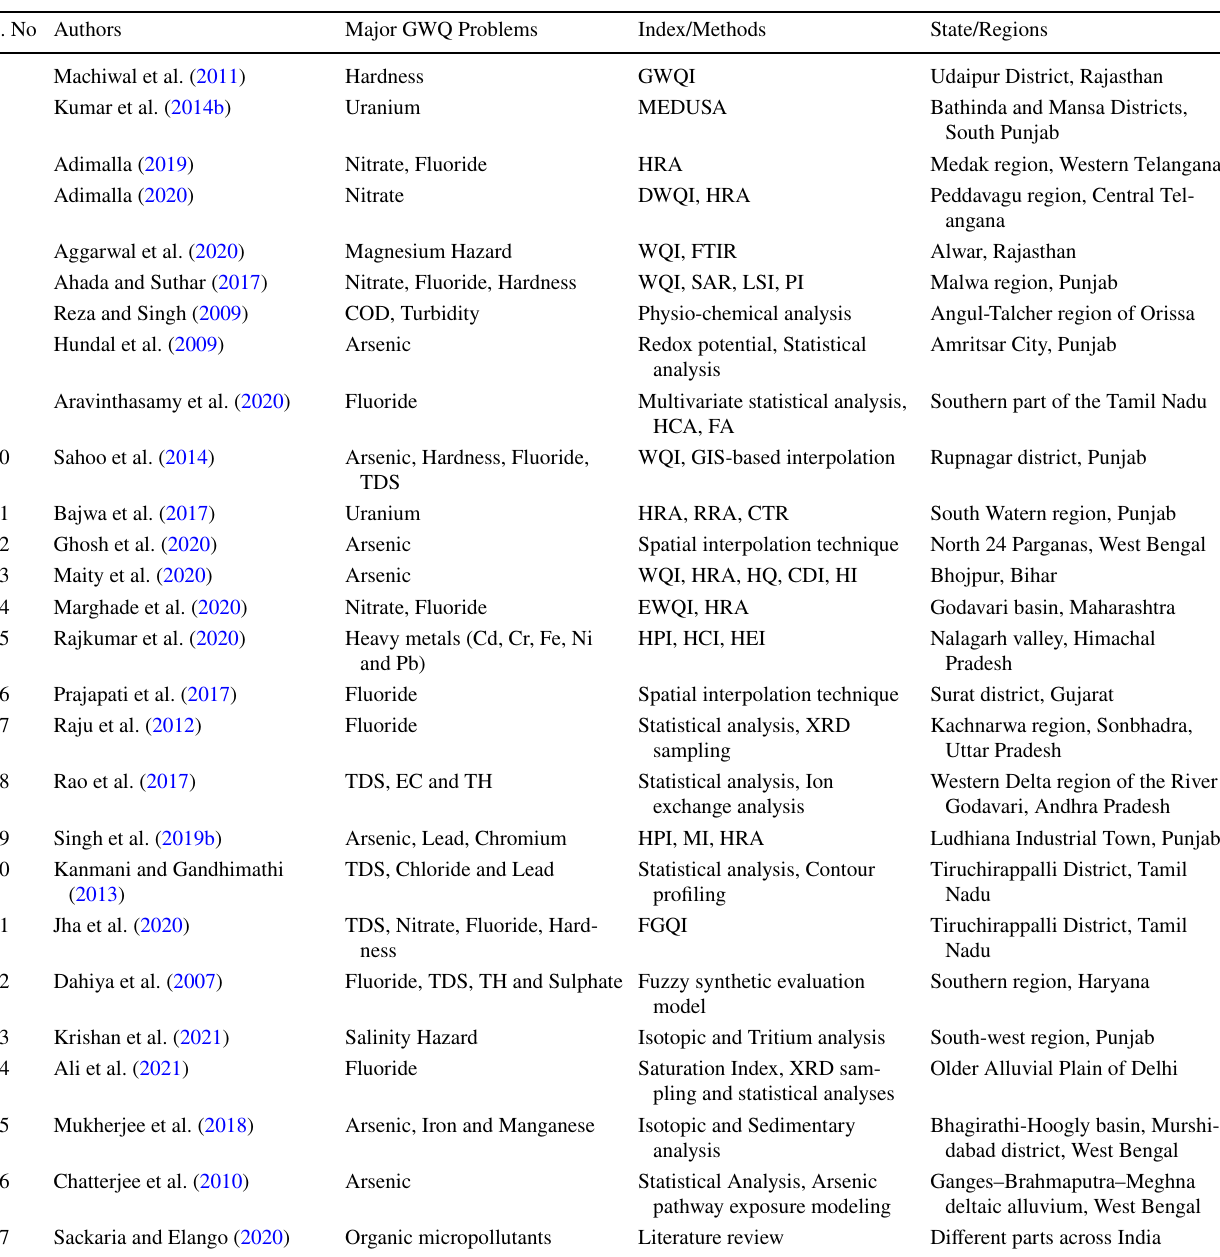
Table 3 Studies for major groundwater quality problems in recent years over